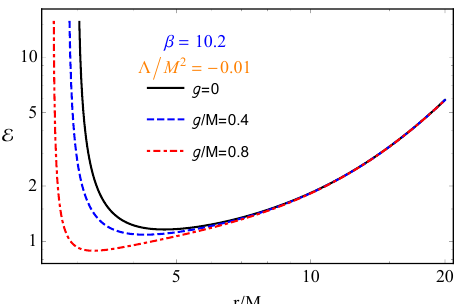
Figure 13. The radial dependence of the specific energy of the magnetized particles around a magnetically charged regular Bardeen black hole in Anti-de Sitter spacetime for circular orbits for the different values of the magnetic charge parameter g and cosmological constant Λ for the fixed value of parameter β = 10.2.